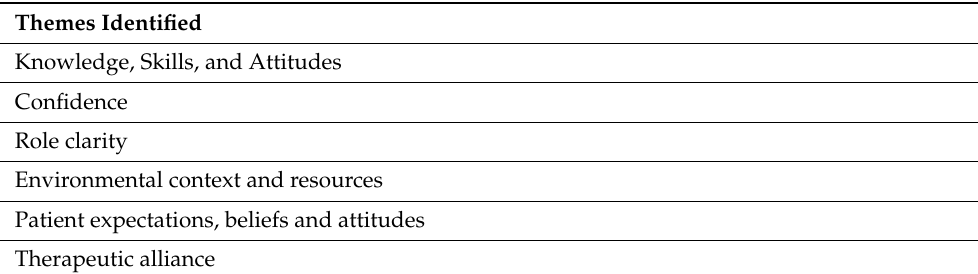
Figure 1. Preferred Reporting Items for Systematic Reviews and Meta-Analyses (PRISMA) flow chart. Table 1. Identified themes of barriers and